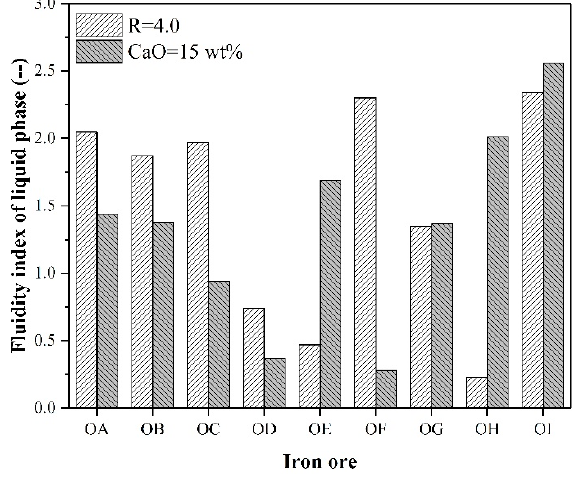
Figure 4. Fluidity index of liquid phase of iron ore.